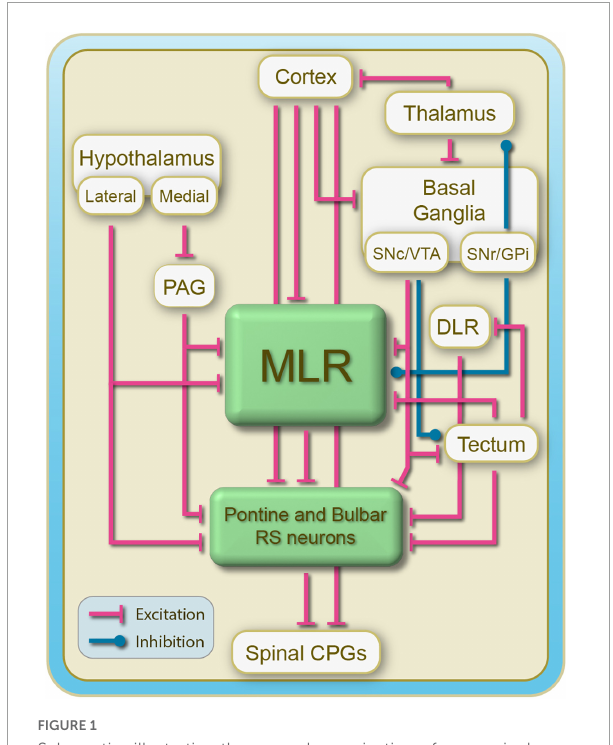
FIGURE1 Schematics illustrating the general organization of supraspinal structures controlling locomotion in vertebrates. Reticulospinal cells constitute a large part of the locomotor-related descending inputs that activate the spinal locomotor CPGs. The MLR receives inputs from the basal ganglia and projects extensively to reticulospinal cells. The cortex projects down to the basal ganglia, the MLR and reticulospinal cells. The basal ganglia and the hypothalamus project down to the MLR as well as to reticulospinal neurons. There is another locomotor region, the DLR, that was identified in several species of vertebrates. Far less is known about this locomotor region that projects directly to reticulospinal neurons.